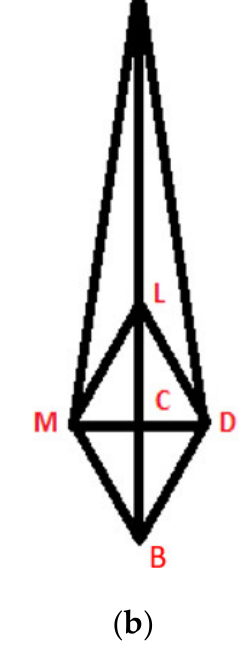
(1) Distances between four points to the cement–enamel junction (CEJ) and the apex (A), AM (mesial point apex), AD (distal point apex), BA (buccal point apex) and LA (lingual point apex) were evaluated with a digital caliber. To calculate the height of the pyramid on the buccal-lingual plane, the triangular sections (ACM and ACD triangles) were considered. The height was calculated, according